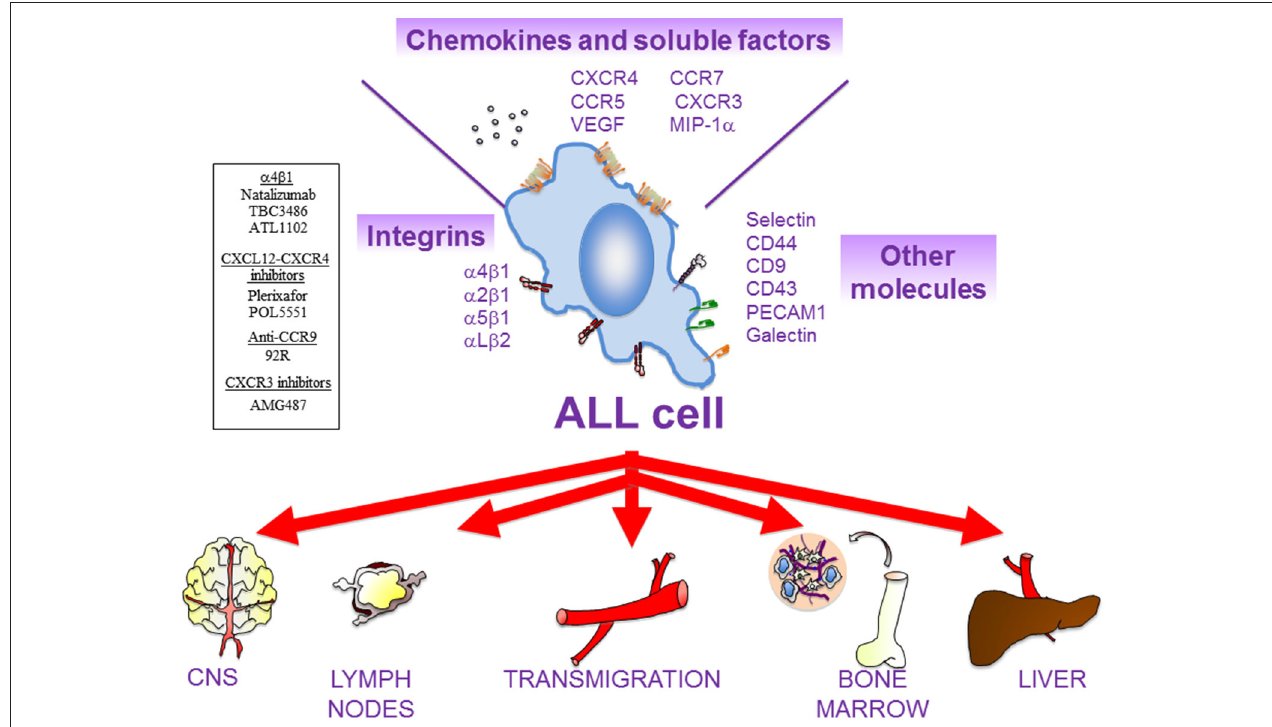
FIGURE 3 | Main actors of ALL cell migration. There are multiple cell surface receptors and soluble molecules that drive ALL cell movement. ALL cells might remain in the BM or colonize multiple extramedullary organs, such as central nervous system (CNS), lymph nodes (LNs), liver, and testes. In general, β 1 integrins ( α 4 β 1, α 2 β 1, α 5 β 1) and the integrin α L β 2 are critical for the homing of ALL cells into the BM and for their infiltration in most of the extramedullary organs. The chemokine receptor CXCR4 mediates ALL cell infiltration into BM, liver, lung, and CNS, whilst CCR7 controls ALL infiltration into CNS and LNs. CXCR3 is also critical for CNS infiltration. Other molecules that might contribute to ALL migration includes MIP-1 α , VEGF, PECAM-1, VE-Cadherin (for CNS infiltration); IL-7 (for LNs); and CD44 (for BM). Several compounds targeting molecular players in ALL cell migration that are currently being tested in preclinical trials are shown on the left.